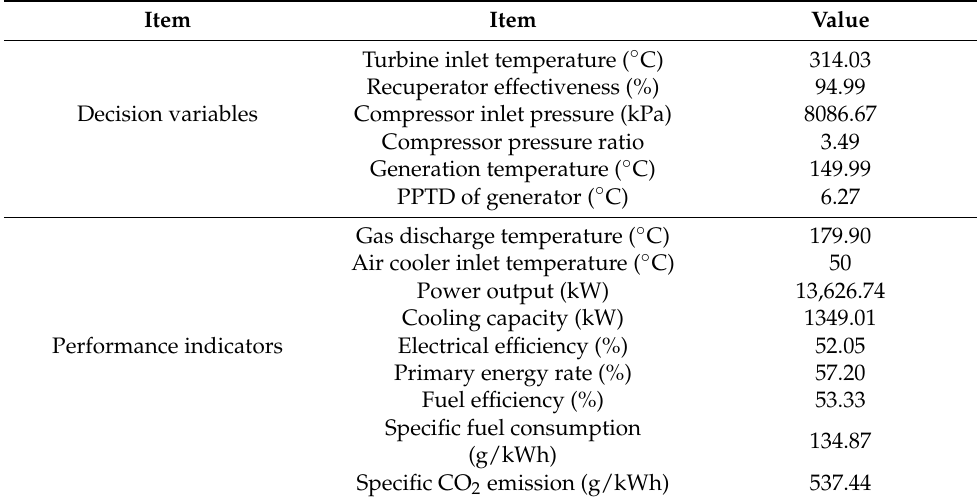
Table 9. Optimization results and the corresponding system